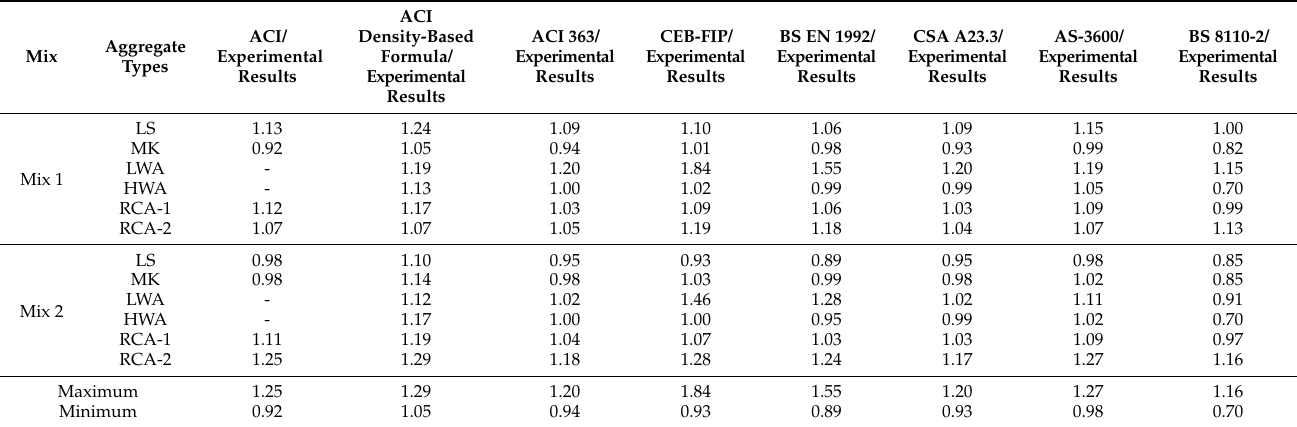
Table 6. Comparisons between the experimentally measured and predicted modulus of elasticity by various design